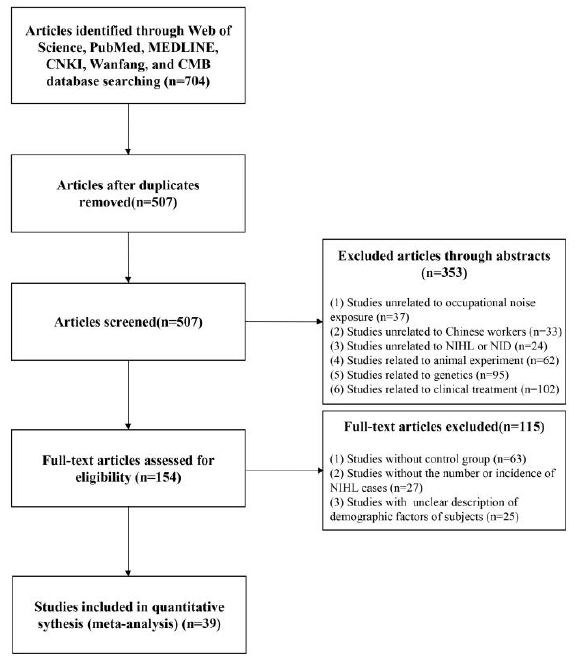
Figure 1. Flow chart of literature screening.